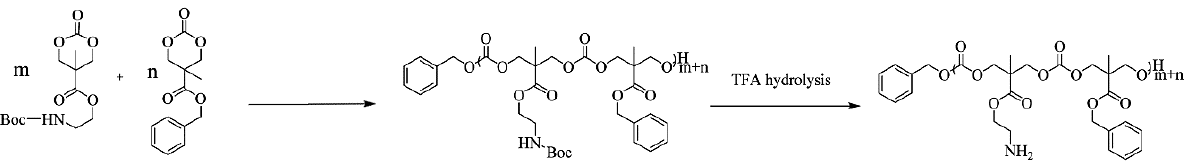
Figure 18. Direct ROP of quaternized cyclic carbonate. The presented examples show that using the ROP, it is relatively easy to obtain cati- onic linear or branched copolymers with a variety of planned chain structures, which have hydrophilic and hydrophobic segments in their structure. The main difficulty in the syn- thesis of these compounds, limiting to a large extent the possibilities of this synthesis, is related to the stage of obtaining the appropriate structure of cyclic monomers active in polymerization. 4.3. Antibacterial Biodegradable Polyesters Aliphatic biodegradable polyesters with antibacterial properties are obtained basi- cally in two ways. The first of them is the ROP of lactones or lactides, and the second is a gradual polymerization, most often polycondensation or polytransesterification of dialco- hols and aliphatic diacids or their esters. Saha et al. obtained an infection-resistant coating on the surface of biodegradable polyester [338]. This polyester was obtained by the polycondensation reaction of a hy- droxyl-protected tartaric acid derivative with 1,6-hexanediol (Figure 19). The resulting polyester was then subjected to the procedure of deprotection of hydroxyl groups, obtain- ing a linear aliphatic polyester containing pendant hydroxyl groups with the chain in about 80% yield. These reactive groups were used to create cationic polymer brushes on its surface by polymerization of RAFT of 2-(Methacryloyloxy) ethyl tri-methylammonium chloride (META). The authors showed a strong antibacterial effect of the surface produced in this way (Figure 19).